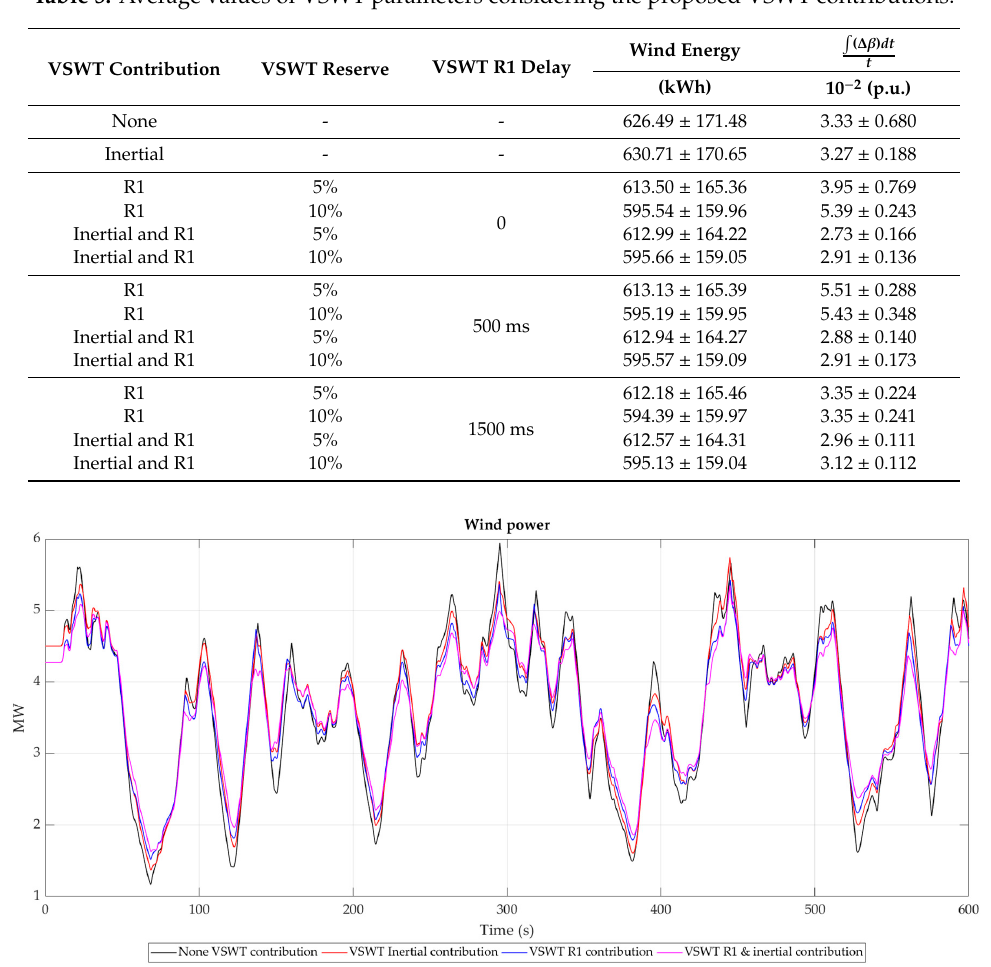
Figure 7. Wind power production in the cases none VSWT contribution, VSWT inertial contribution, R1 contribution and R1 and inertial contribution (5% power reserve).